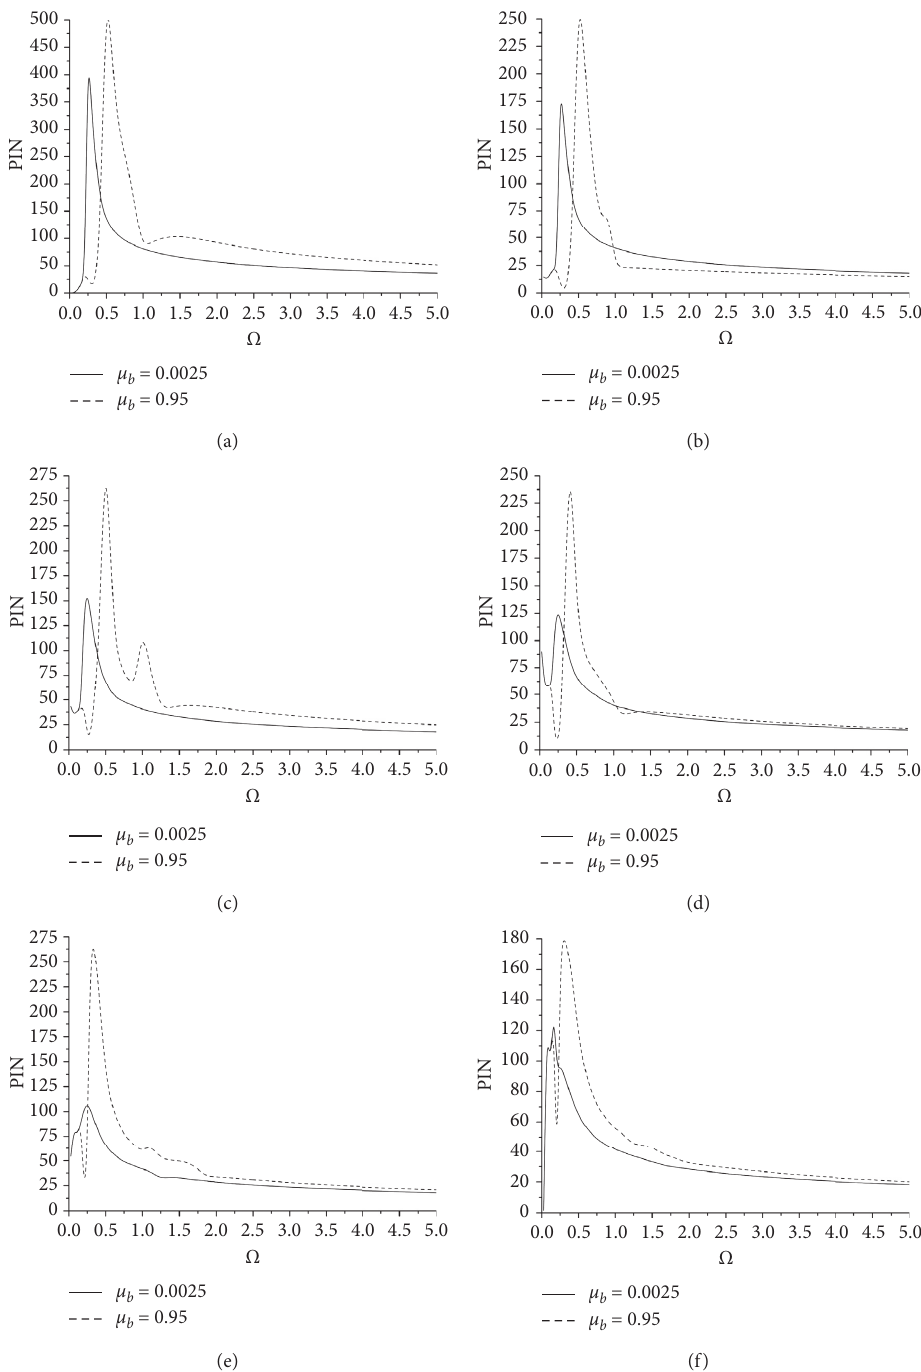
Figure 5: Input power flow under different expansive coefficients of viscosity. (a) n � 0. (b) n � 1. (c) n � 2. (d) n � 3. (e) n � 4. (f) n �